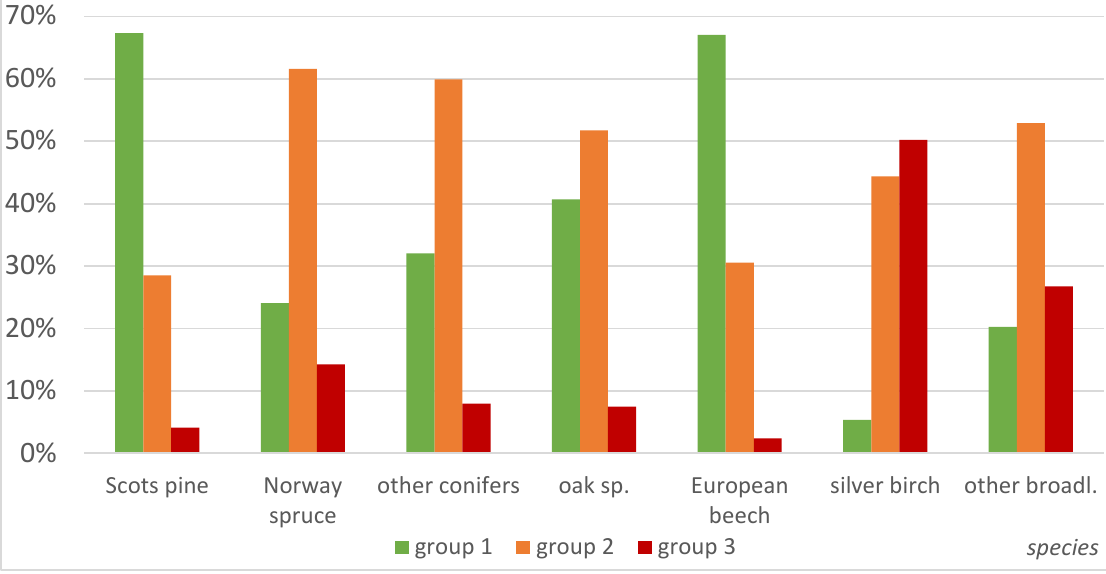
Figure 4. Need and urgency of intervention in stands according to the prevailing species.